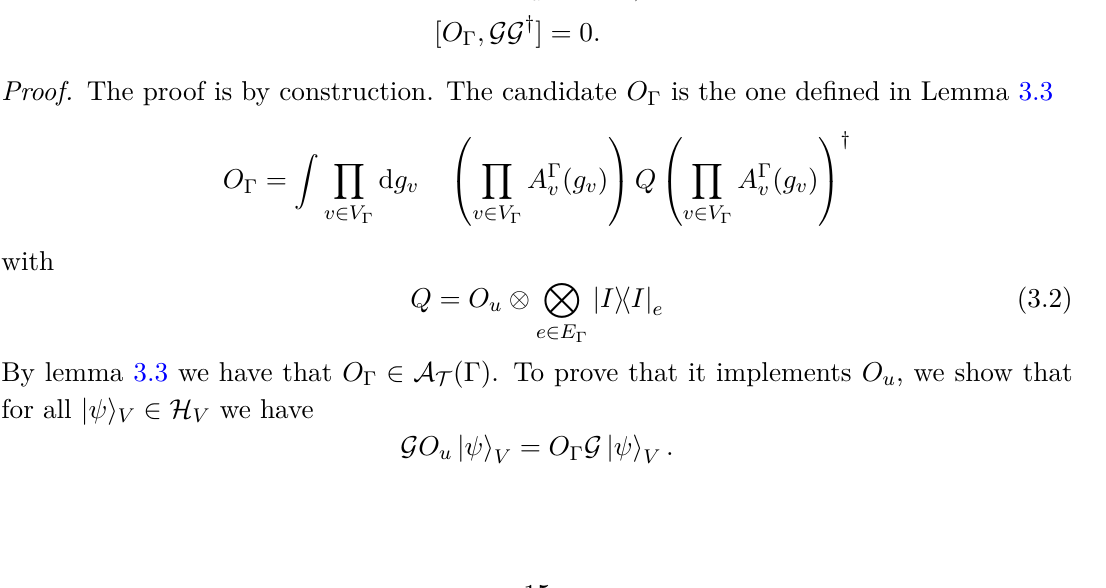
Figure 1. Mapping of an S operator under G . The black and white dots are vertices labeled 1 and 0 respectively. The blue dot represents an operator acting on a vertex v ∈ V green line represents an operator acting on all the edges it lies on. The localized S operator can be implemented on T via an operator supported on v , as well as all the edges lying along a path from v to any v 0 ∈ V 0